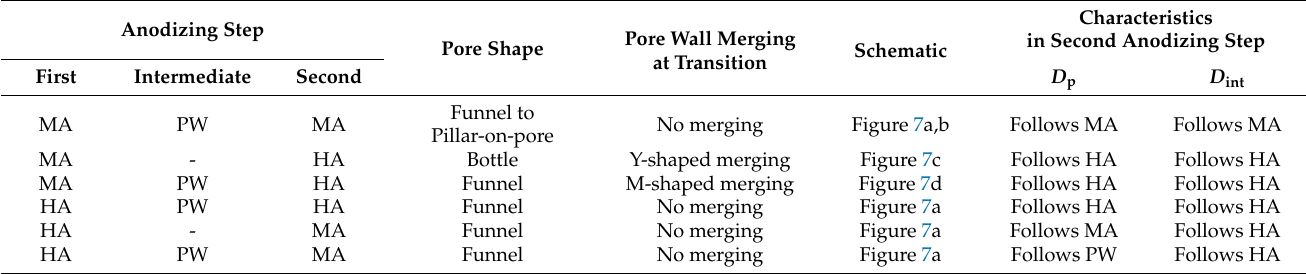
Table 3. Types of nanopore structures obtainable using the stepwise anodizing processes with an intermediate pore-widening